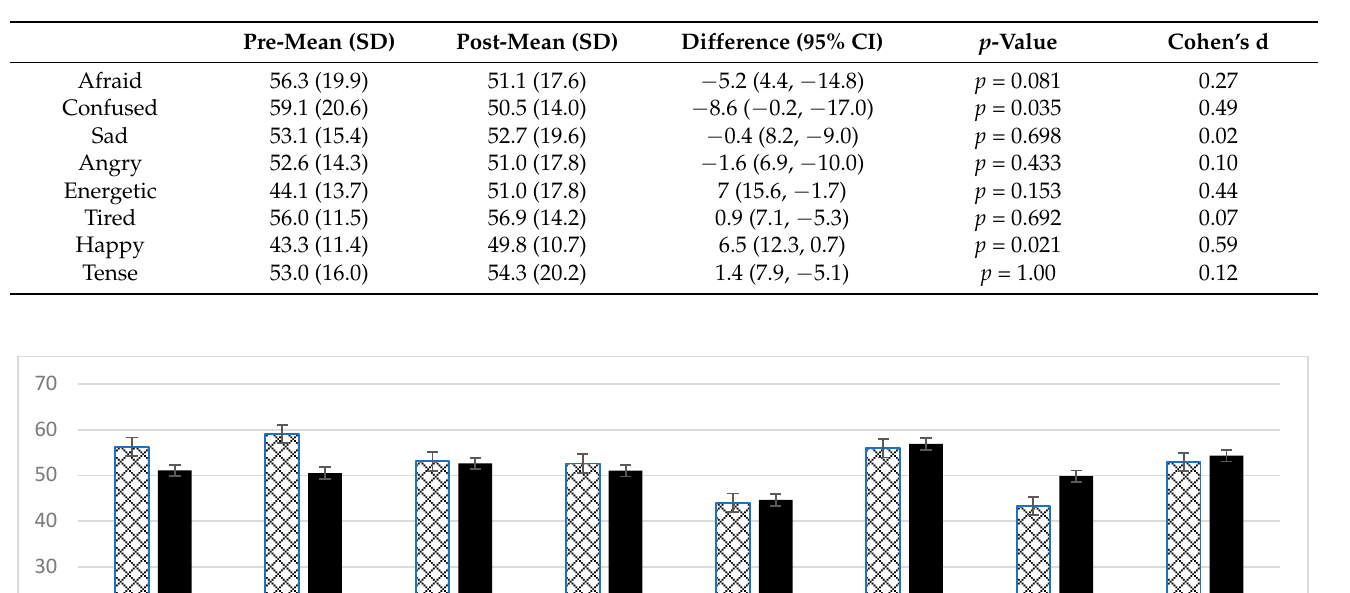
Table 4. Responses to the Visual Analog Mood Scale ( n = 24).